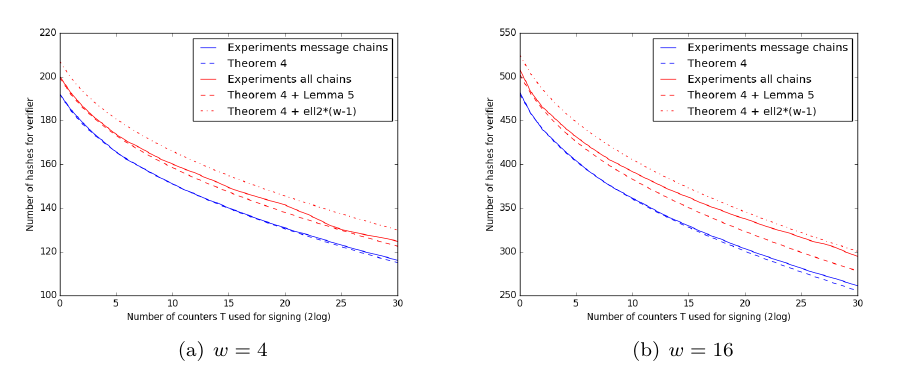
Figure 6.1: Average number of hash computations for signature verification of the first ‘ 1 message chains as a function of t . Solid red line: average over 10 3 experiments. Dashed red line: estimate of Theorem 4. In blue all ‘ = ‘ 1 + ‘ 2 hash chains are taken into account. Solid blue line: average over 10 3 experiments. Dashed blue line: estimate of Theorem 4 for ‘ 1 + mean of Lemma 4 for each ‘ 2 checksum chain. Dash-dotted blue line: estimate of Theorem 4 for ‘ 1 + maximum value w − 1 for each ‘ 2 checksum